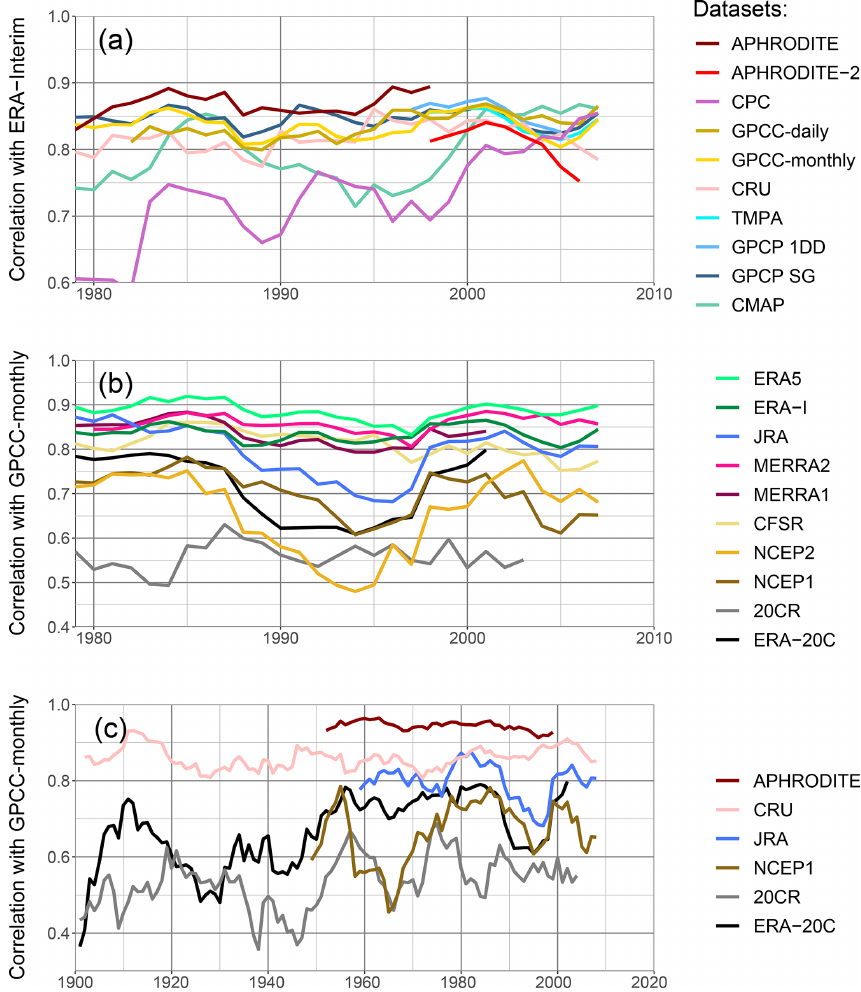
Figure 8. Correlation of monthly anomaly on a running 10-year window for the upper Indus. The monthly mean needed for the anomaly is computed relatively to the 10-year window. The years on the x axis are the start of the 10-year windows. Similarly to in Fig. 5, a set of datasets is tested against a reference. In (a) observational datasets are tested against ERA-Interim. Panel (b) shows the correlation between the reanalysis and GPCC-monthly. Lastly, (c) presents the longest datasets, except GPCC-monthly which is used as